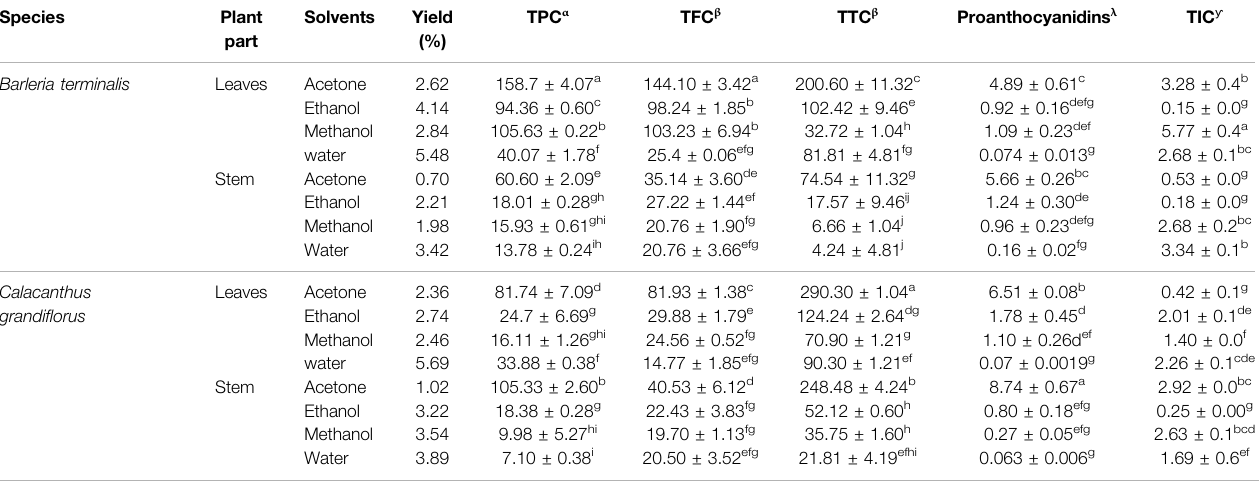
TABLE1| Extractyield,totalphenolicscontent(TPC),total fl avonoidscontent(TFC),totaltanninscontent(TTC),proanthocyanidinsandtotaliridoidscontent(TIC)ofdifferent solvent extracts of B. terminalis and C. grandi fl orus .